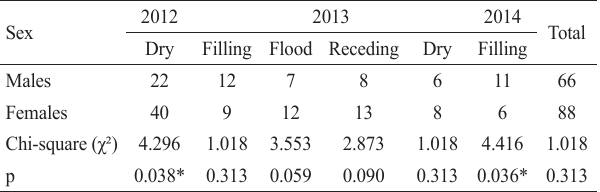
Tab. 1. Sex ratio of the red-tailed catfish, Phractocephalus hemioliopterus , specimens collected from the Xingu River in Pará, Brazil. *indicates a significant difference between males and females.